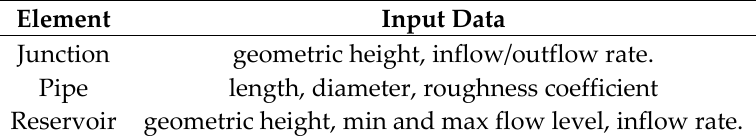
Table 1. Input data to be provided for some network’s elements.